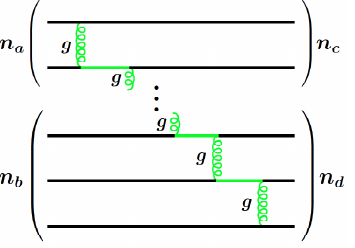
Figure 1. Hard-gluon exchange process in an exclusive hadron reaction. See text for details. This constituent-counting rule was confirmed by high-energy exclusive reactions.